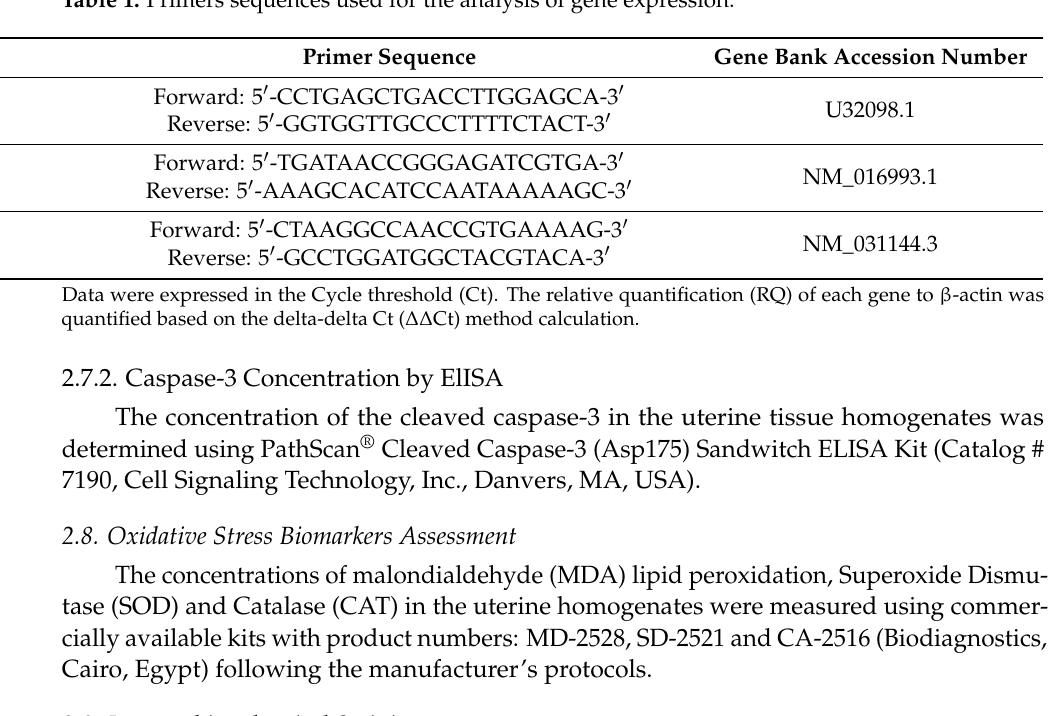
Table 1. Primers sequences used for the analysis of gene